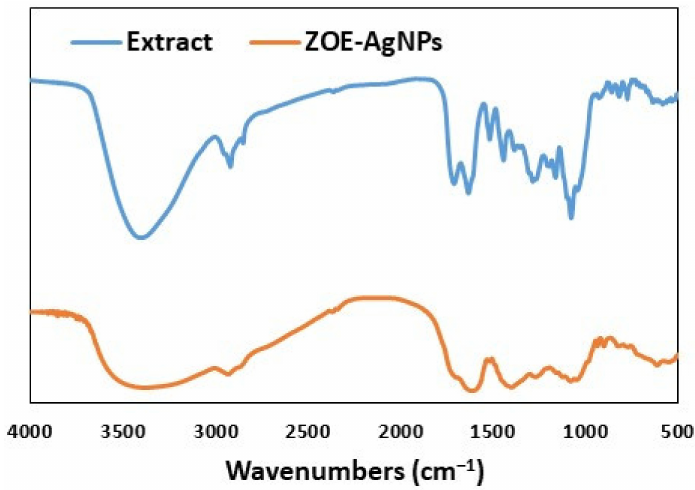
Figure 4. FT-IR spectra of AgNPs synthesized with